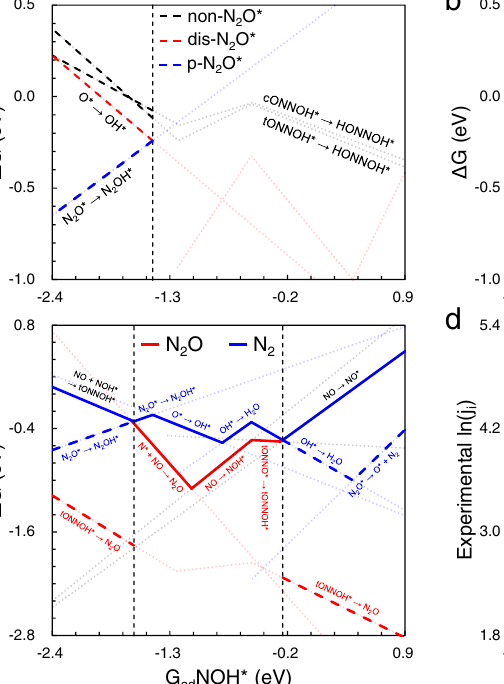
analysis for N 2 and N 2 O productions are colored in blue and red, respectively, where the Δ G RPD -limiting steps and key steps for product selection are shown in solidanddashedlines,respectively. d Themeasuredactivitytrends( fi ttedblueand red lines) for N 2 and N 2 O productions 17